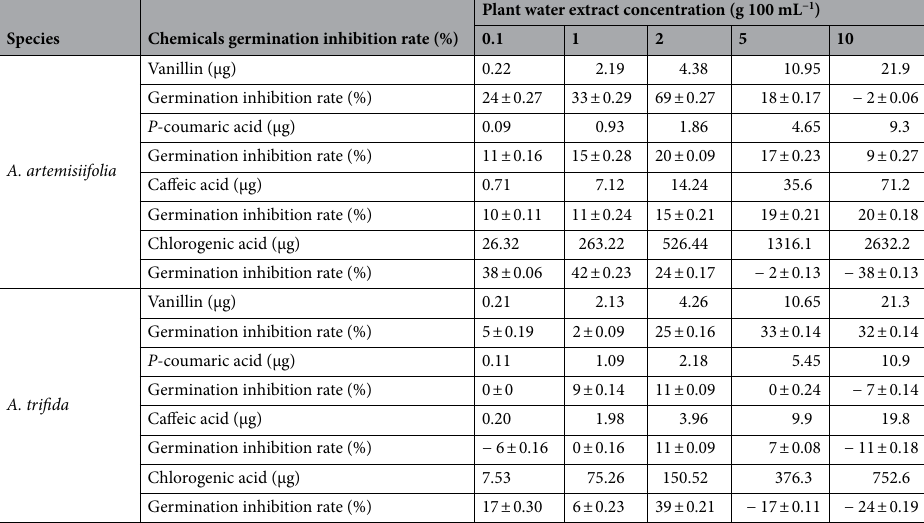
Table 1. Effects of different concentrations of water extracts of A. artemisiifolia and A. trifida on the contents of autotoxins and seed germination ( M ± SD ). Positive value of germination inhibition rate (%) means promoting germination, negative value means inhibiting germination.